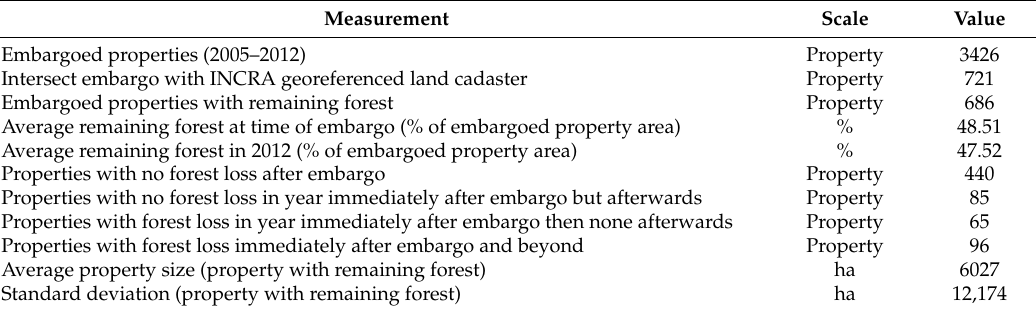
Table 3. Embargoed properties in study area in Mato Gross and deforestation deterrence